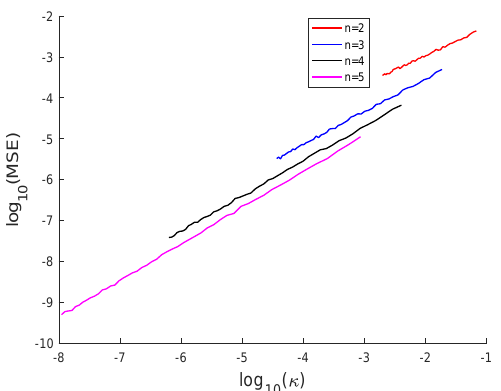
Figure 13. log (MSE) vs. logarithm of extrinsic curvature (log 10